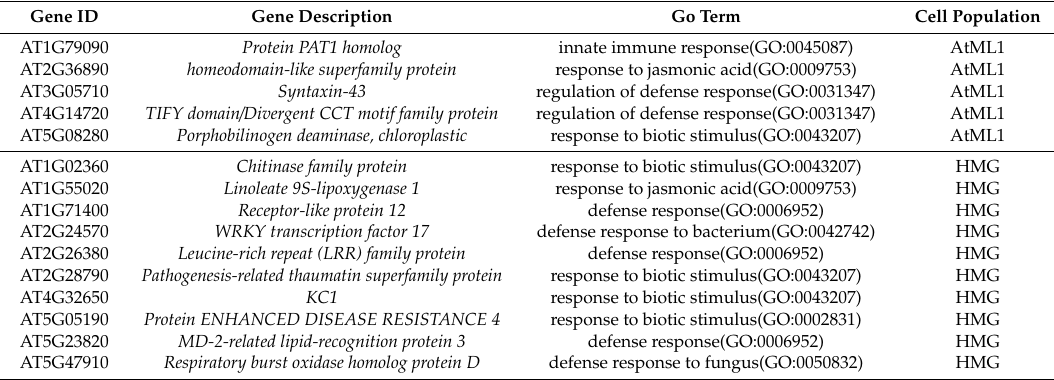
Table 3. Immune defense functions of DEGs of AtML1 and HMG cellular